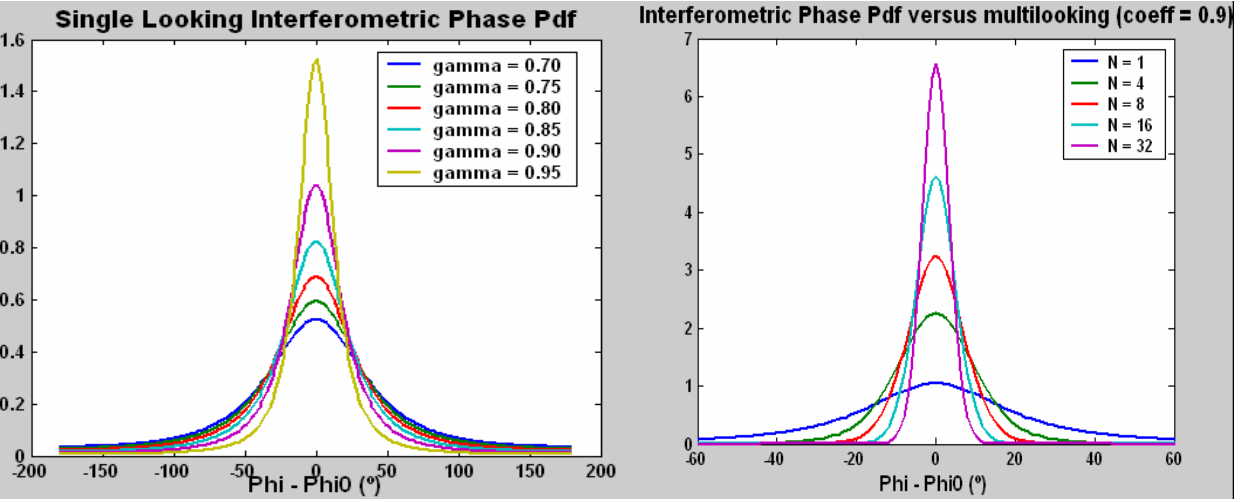
Figure 3. Interferometric phase densities of probability versus coherence (a) and multi looking (b).